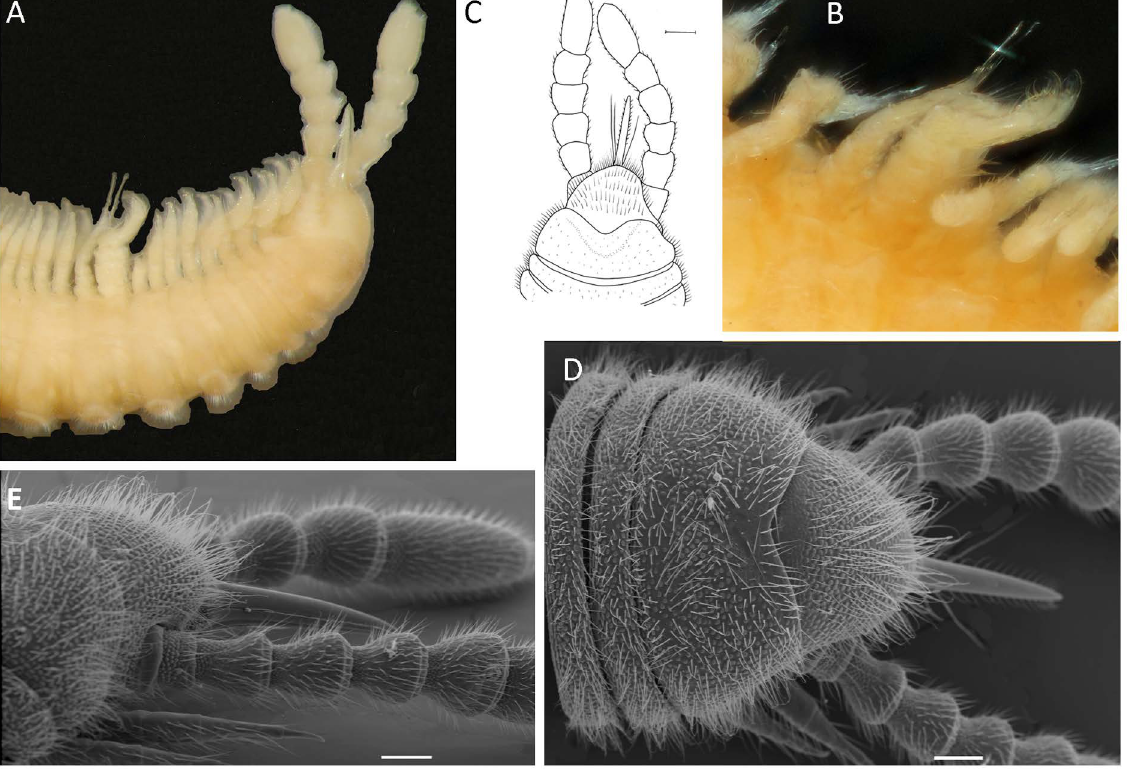
Fig. 4. Columbianum nahvalr sp. nov. A . Head and anterior body rings of male, showing the appearance of gonopods in a ‘relaxed specimen’. Body width approximately 1 mm. B . Close up of gonopods in a ‘relaxed’ specimen. Body width approximately 1 mm. C . Head of holotype male in dorsal view. Note long setae originating from base of rostrum. D . Head and rostrum of female in dorsal view. E . Head and rostrum of female in lateral view. Scale bars = C = 0.2 mm; D–E = 0.1